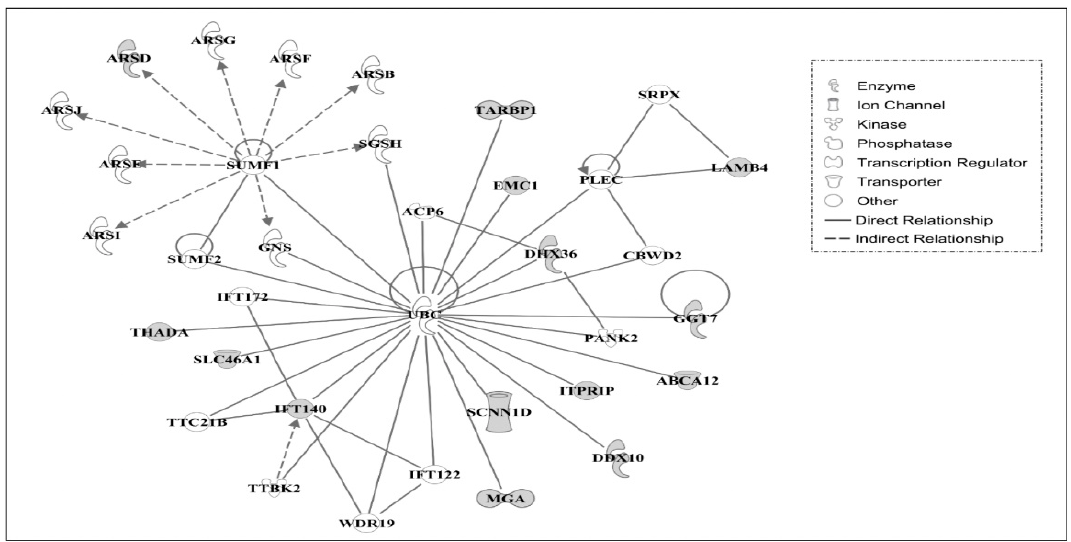
Figure 3. Gene network #1. Molecular interactions among the important focus molecules are displayed. Gray symbols show the genes found in the list of SNP while white symbols indicate neighboring genes that are functionally associated, but not included, in the gene list of SNP. Symbols for each molecule are presented according to molecular functions and type of interactions.